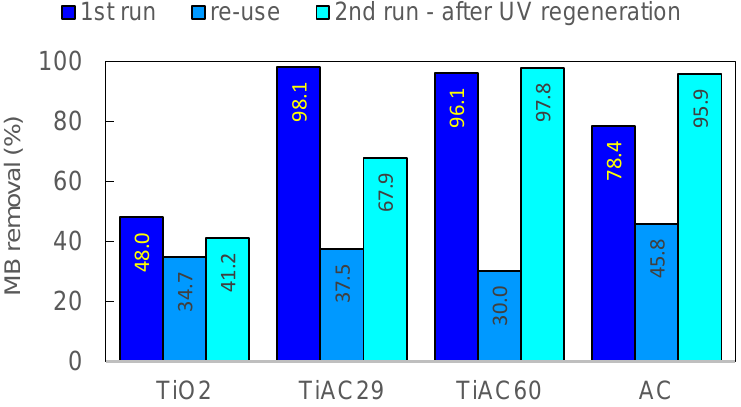
Figure 13. Comparison of MB removal percentage during combined adsorption + photocatalytic removal of MB, between the original (first run), re-used without regeneration (reuse) and UV-regenerated catalysts (second run after UV regeneration for 90 min).